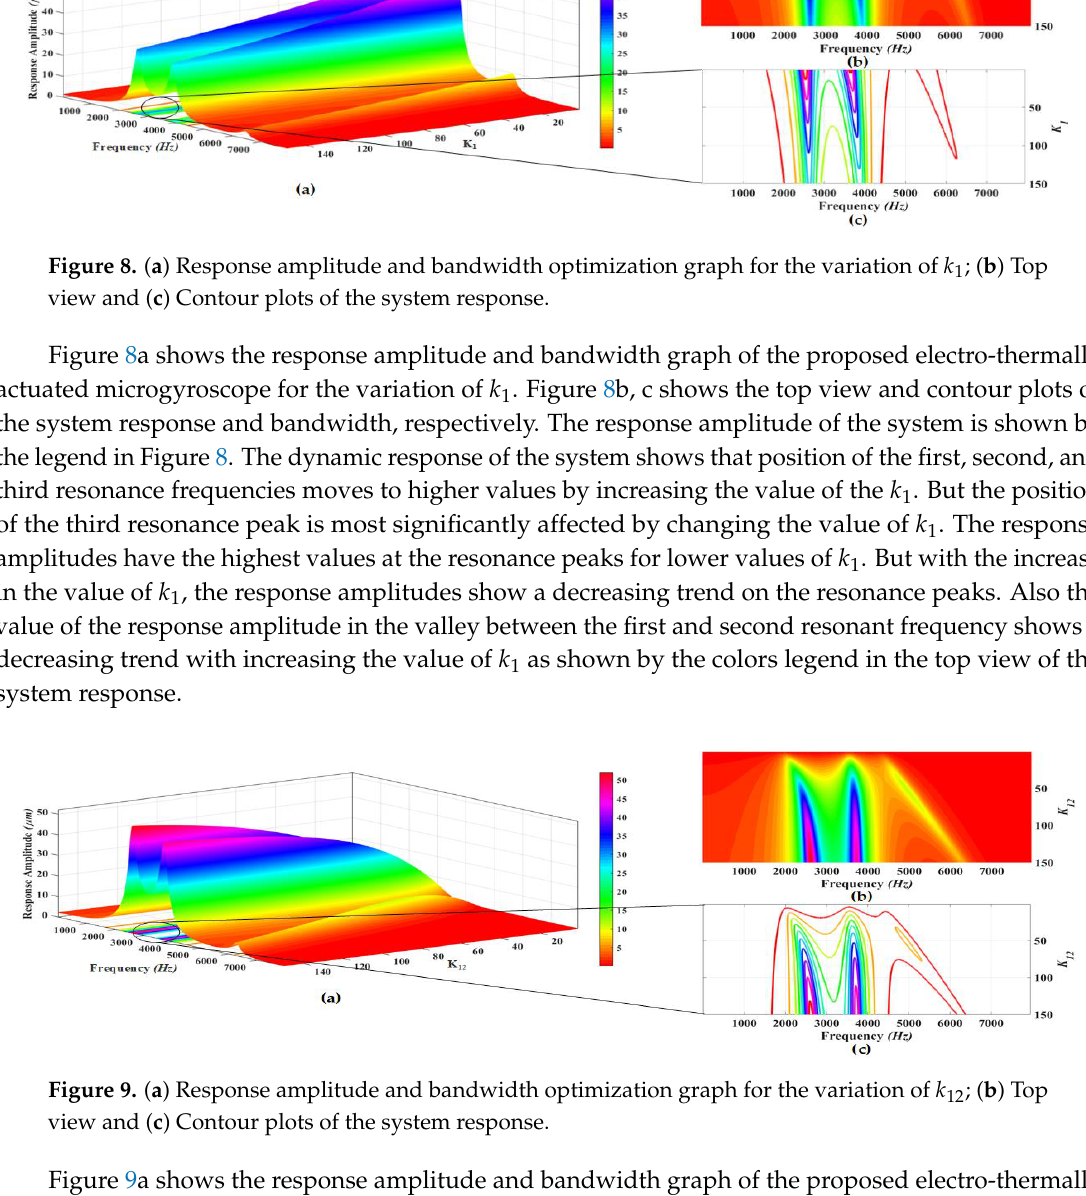
9 of 25 Figure 7. Stiffness values of the electro-thermal actuator with temperature variations. 4. Parametric Design Optimization of the Proposed MEMS Gyroscope The proposed MEMS gyroscope is designed to be operated in region between the first two drive mode resonance peaks which allows to minimize the effect of environmental variations and microfabrication process uncertainties. Thus, to maximize the gain in the flat operational region between first two resonant peaks, a parametric design optimization is carried out by varying the stiffness values of different suspensions connecting the masses to each other and to substrate. The parametric optimization of the proposed gyroscope dynamical model is done by maximizing the concerned variables response using grid search method [34,35]. In this method, the maxima of curves are explored for certain realizable range of values for the parameters being optimized. The 3D graphs are plotted using analytical model and the system response including gain in the region between